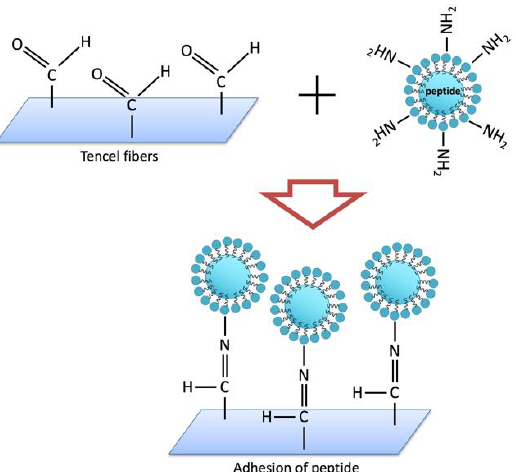
Figure 3. FT-IR spectra of nano-CuO/Tencel membranes with different plasma treatment times.